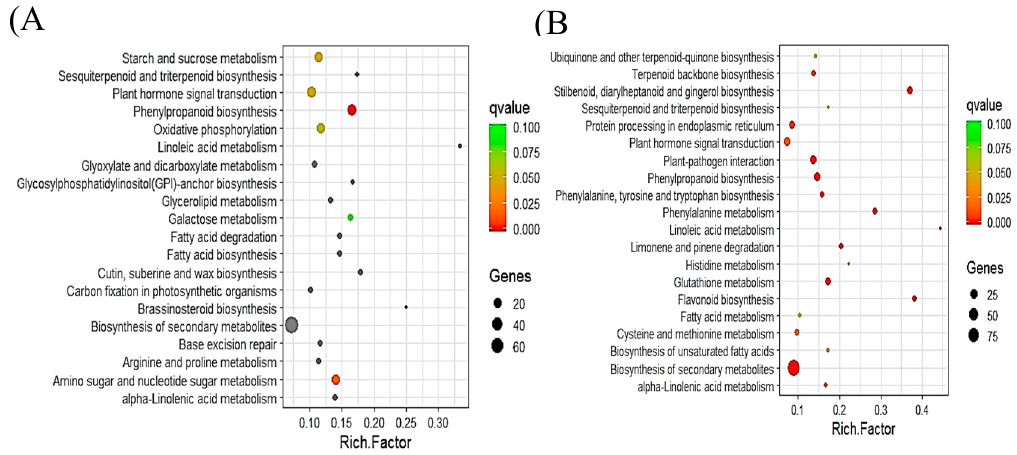
Figure 3. Top 20 enriched KEGG pathways among upregulated ( A ) and downregulated ( B ) DEGs in PI 257145 versus PI 224448. Rich factor is the ratio of the number of DEGs to the total gene number in a pathway. Here, q-value is a corrected p -value. The color and size of the dots represent the range of q-value and the number of DEGs mapped to the indicated pathways, respectively.